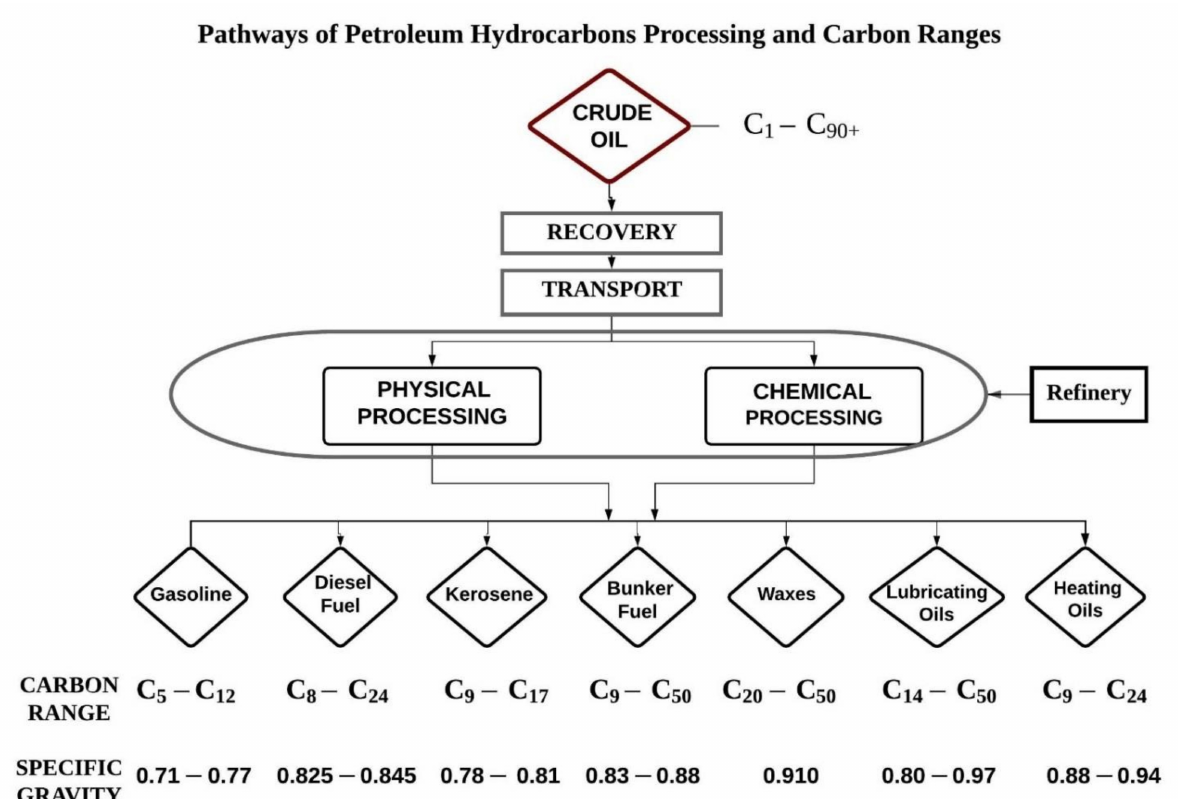
Figure 1. Petroleum hydrocarbon products and fractions by carbon ranges. The stability and behavior of petroleum in seawater depends on its relative density (the relationship between the density of petroleum and pure water) and the distillation characteristics (definition of volatility, large quantities of resin, asphalt, wax, etc. reduces the volatility of oil), viscosity (flow resistance that varies with temperature) and point of pour [29]. Due to the formation of water or gas, or liquids and chemicals extracted during operations, inorganic salts like sodium chloride, magnesium chloride and other inorganic salts often follow crude oil from wells. Heavy crude oils produce large quantities of difficult to process complex hydrocarbons, such as polynuclear aromatic compounds (PNA), PAHs, alkyl aromatic compounds, heteroatoms, and metal materials. Sulphur, oxygen, nitrogen, and metal atoms are typical heteroatoms in hydrocarbons